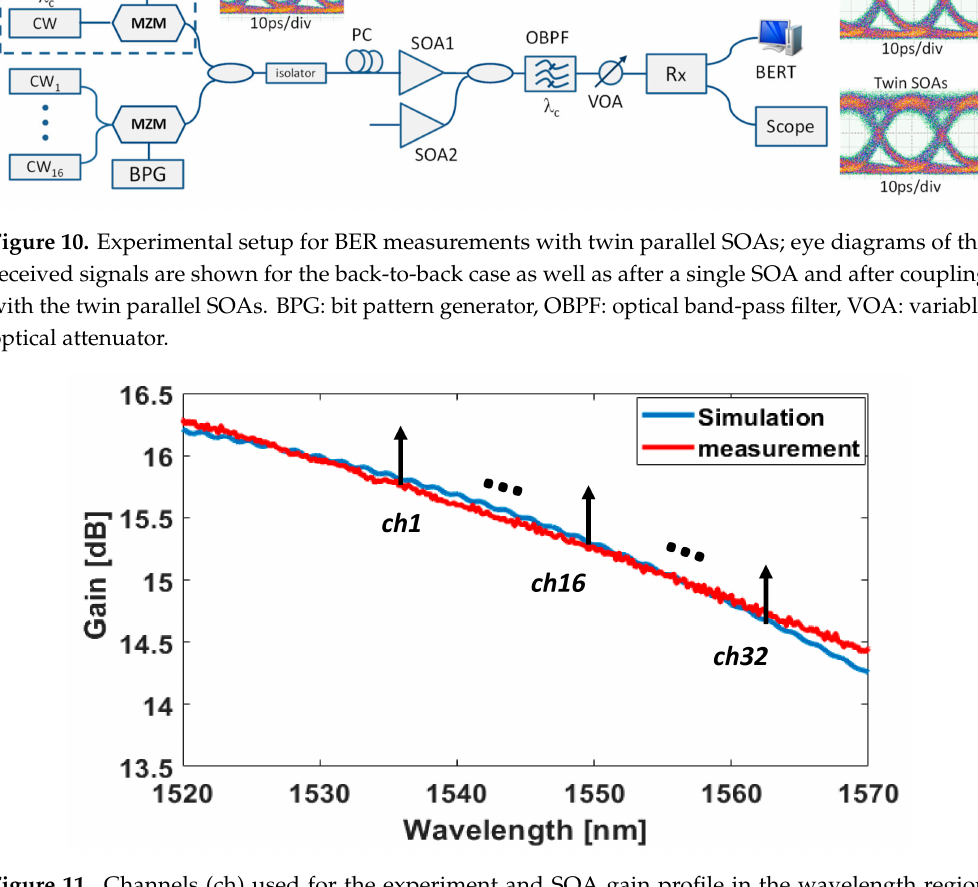
Figure 11. Channels (ch) used for the experiment and SOA gain profile in the wavelength region of